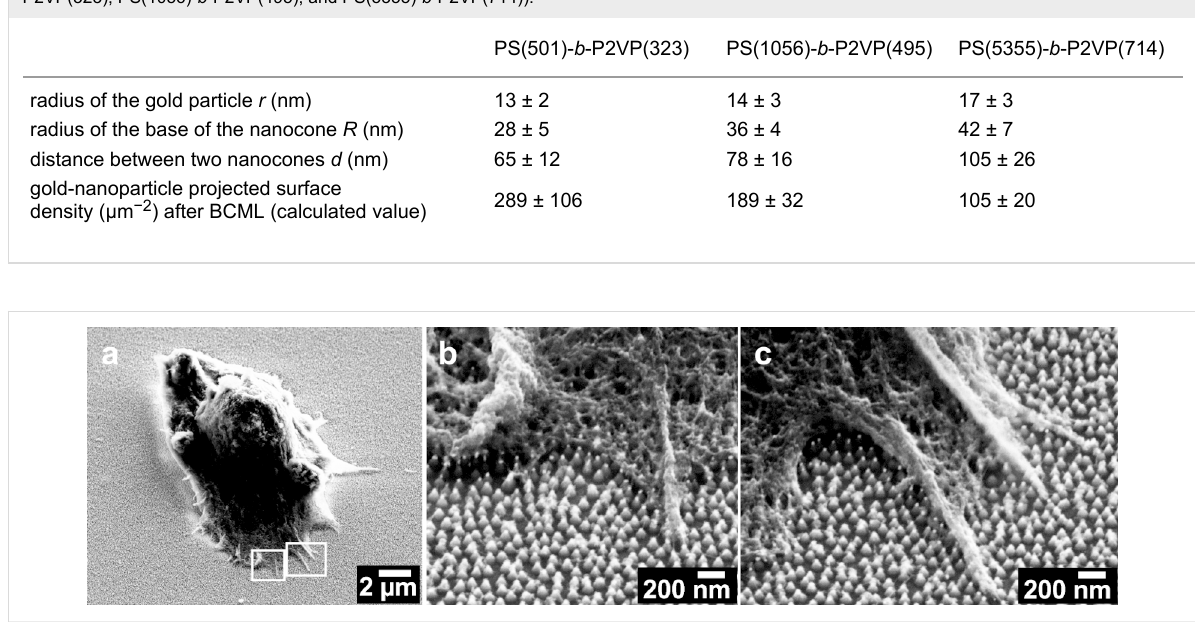
diblock copolymer chain length. The structures had an average areal density of particles of 289 ± 106, 189 ± 32, and 105 ± 20 µm − 2 for the substrates fabricated from polymer 501, polymer 1056 and polymer 5355,